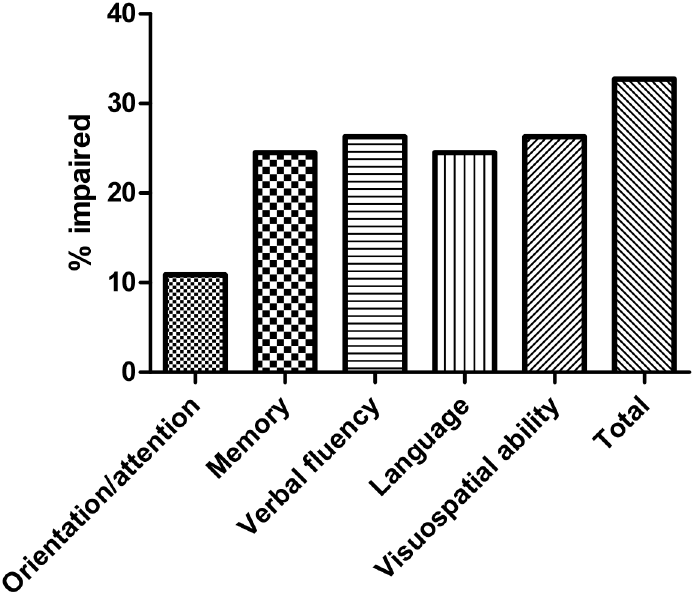
Fig 1. The frequencies of the ACE-R scores for MSA patients less than 1.5 standard deviations below the mean of healthy controls. (Table 3). The frequencies of each subtest score of FAB < 3 in MSA patients are presented in Fig 2. The mean FBI score was 5.5 ± 4.5. Based on the FBI score, 22.7% patients showed mild fron- tal behavior changes (FBI score 1 – 3), 57.2% patients showed moderate frontal behavior